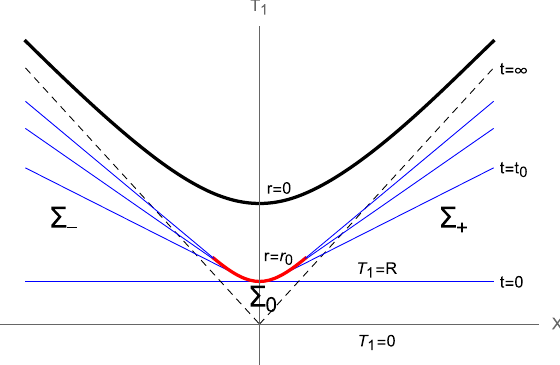
Fig. 5 Nice slice foliation of a Schwarzschild BH in Kruskal coordi- nates coordinates ( T 1 , X 1 ) , to the coordinates ( t , r ) . For